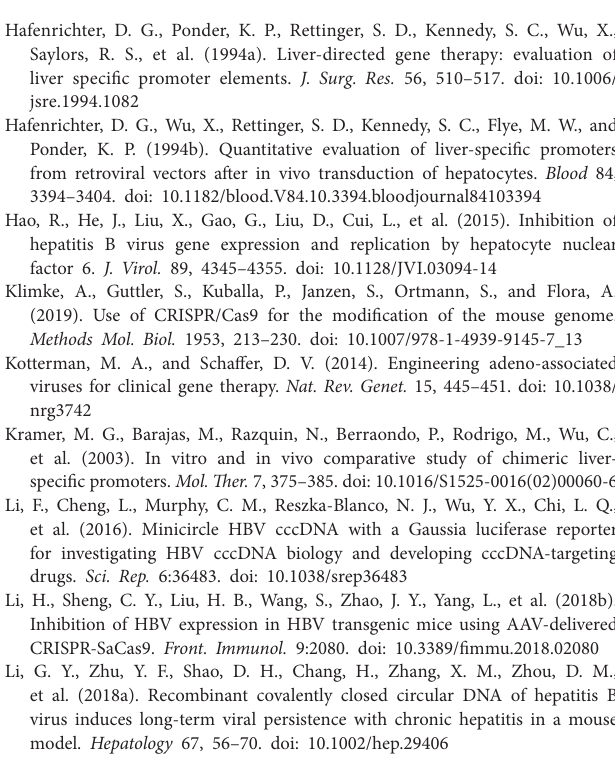
Supplementary Figure S1 | Sequence alignment of HBV-specific gRNAs and their target sequences. The sequence of the HBV G genotype marked 36 bp was omitted. Supplementary Table S1 | Primers for